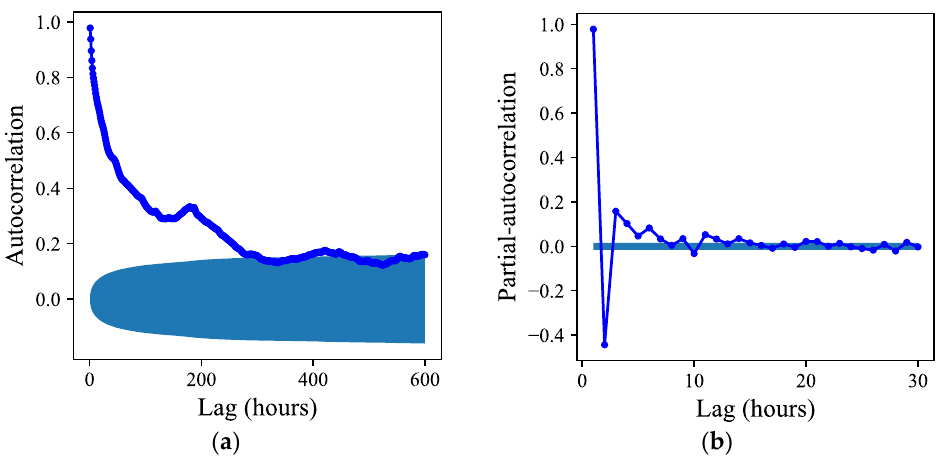
Figure 4. ( a ) Autocorrelation function (ACF) and ( b ) partial-autocorrelation function (PACF) of the Matadero-Sayausí (Tomebamba catchment) discharge series. The blue hatch indicates in each case the correspondent 95% confidence interval.